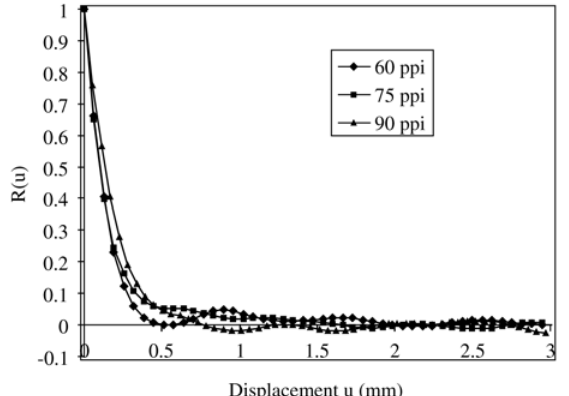
Figure 15. Comparison of the 60, 75 and 90 ppi ceramic foams’ normalized autocorrelation.